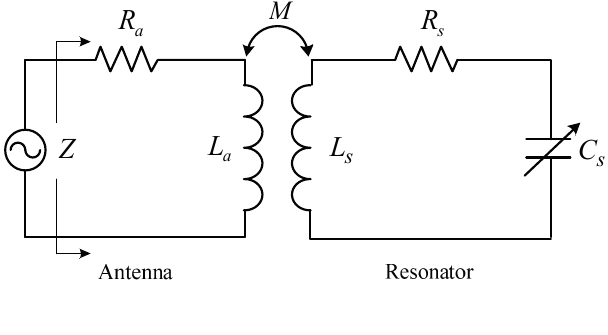
Figure 1. Equivalent circuit.